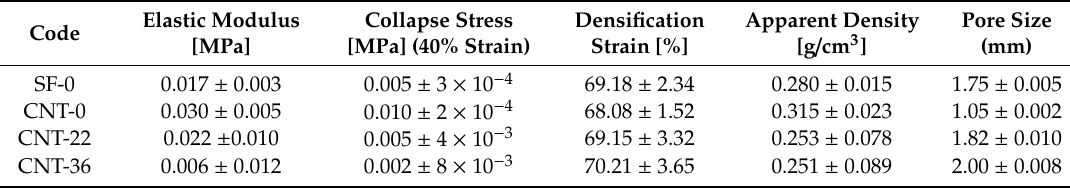
Table 2. CNT-silicone composite foams structural properties and compressive parameters: elastic modulus, collapse stress, densification strain, apparent density, and pore size.